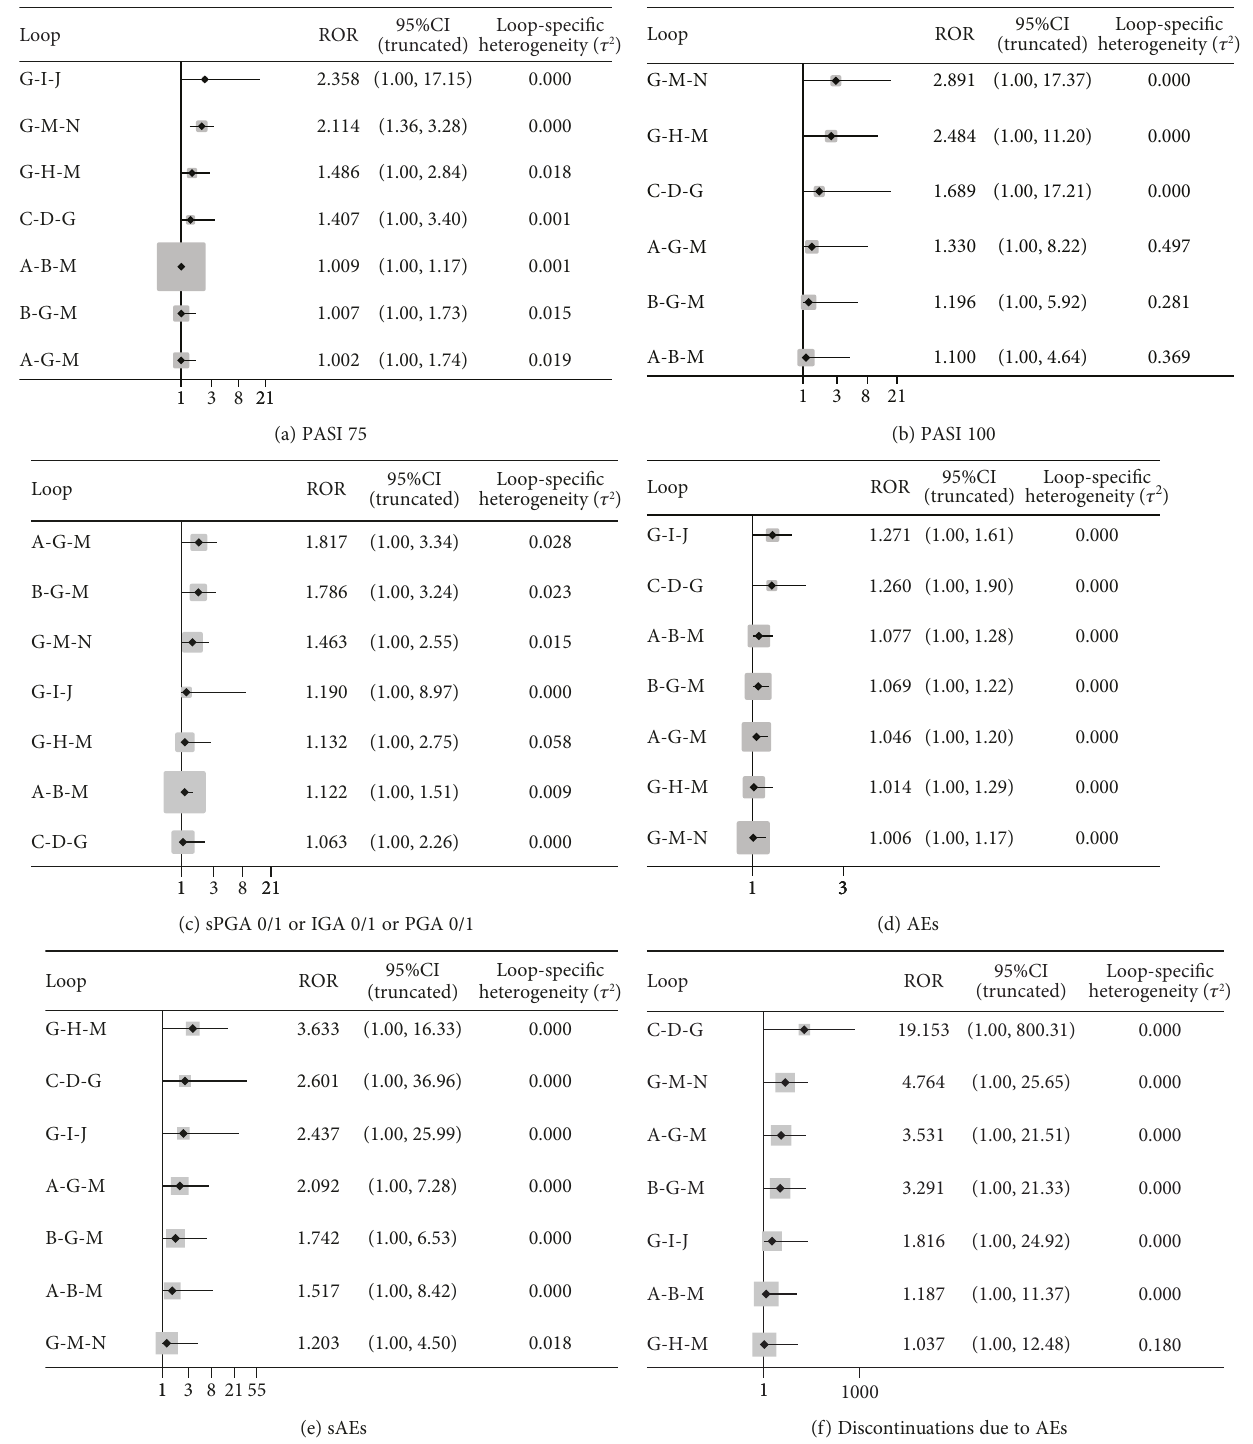
Figure 11: Inconsistency in closed loops for all the outcomes. The graph shows the estimates of di ff erences between direct and indirect comparisons as represented by the relative odds ratio (ROR) with 95% CIs. PASI 75: the percentages of patients with a 75% improvement from baseline in the PASI score; PASI 100: the percentages of patients with a 100% improvement from baseline in the PASI score; sPGA 0/1: static physician ’ s global assessment score of 0 or 1; IGA 0/1: a response of 0 or 1 on the modi fi ed investigator ’ s global assessment; PGA 0/1: physician ’ s global assessment score of 0 or 1; AEs: adverse events; sAEs: serious adverse events. Alphabetic reference: A, brodalumab 140 mg; B, brodalumab 210mg; C, guselkumab 100 mg; D, guselkumab 50 mg; E, ixekizumab 80 mg Q2W; F, ixekizumab 80mg Q4W; G, placebo; H, risankizumab 150 mg; I, secukinumab 150 mg; J, secukinumab 300 mg; K, tildrakizumab 100 mg; L, tildrakizumab 200mg; M, ustekinumab 45mg; and N, ustekinumab 90